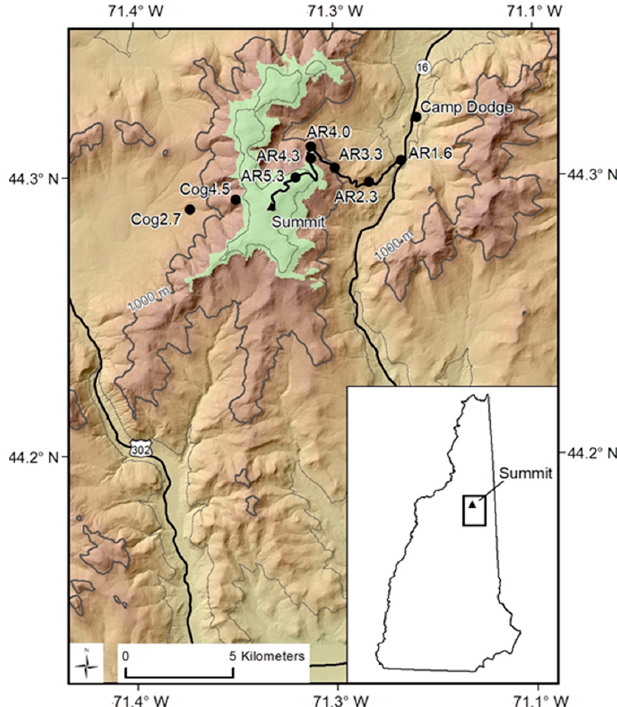
Figure 1. Map of research sites on Mount Washington, New Hampshire. The topographic map shows mesonet sites (numbers following “Cog” and “AR”, Auto Road, refer to their elevations in thousands of feet), the Auto Road (black line to summit), area above treeline (green shaded), and Camp Dodge (valley location measuring ozone).